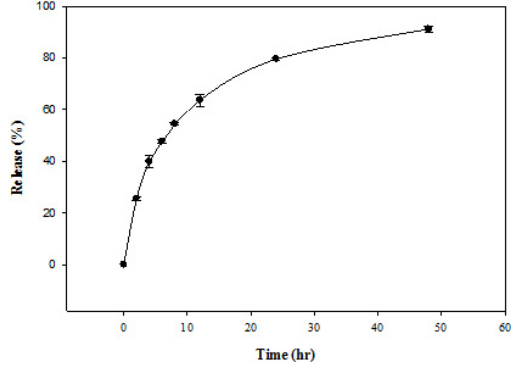
Fig. 1. % Drug release of Mesalamine loaded chitosan.